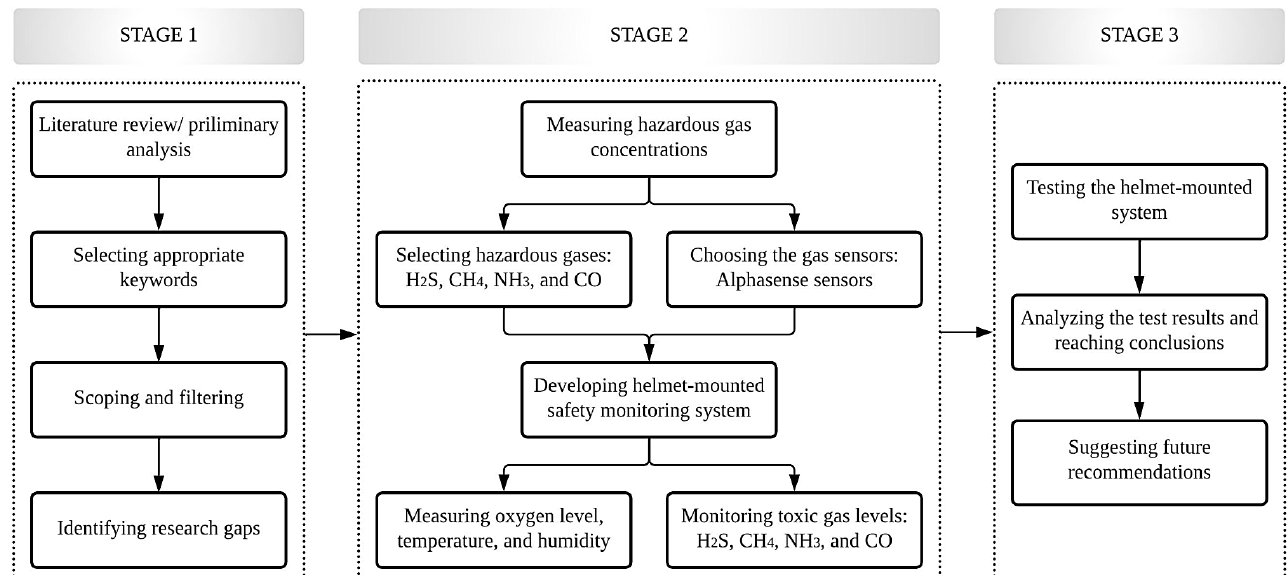
Figure 1. Overall study methodology.